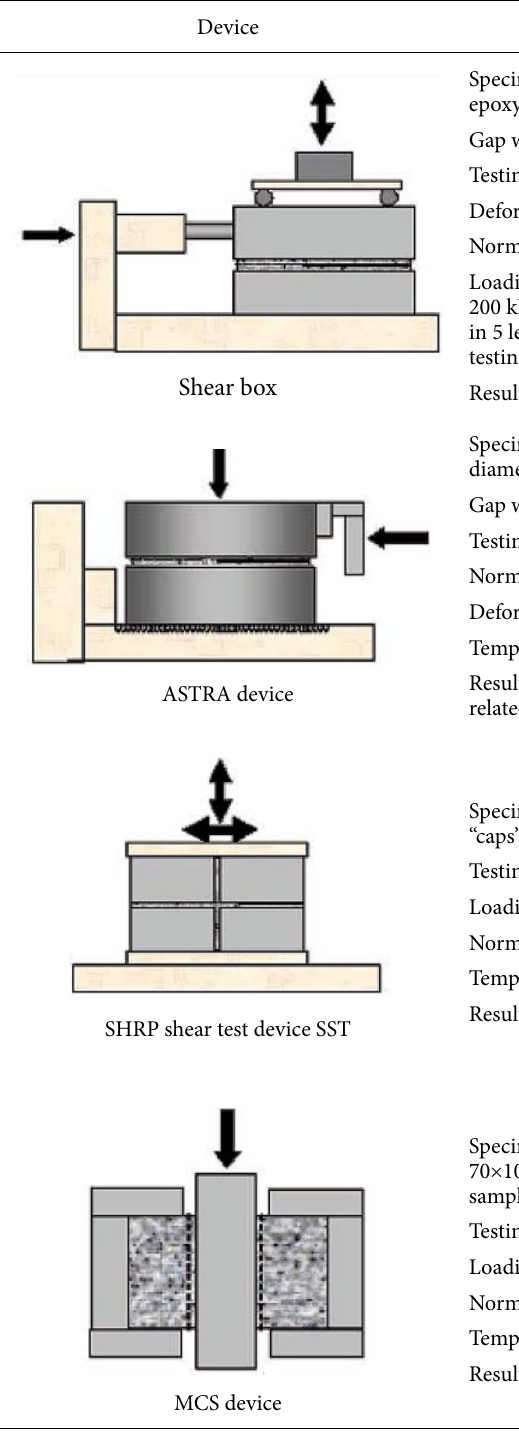
Table 3. Simple shear test